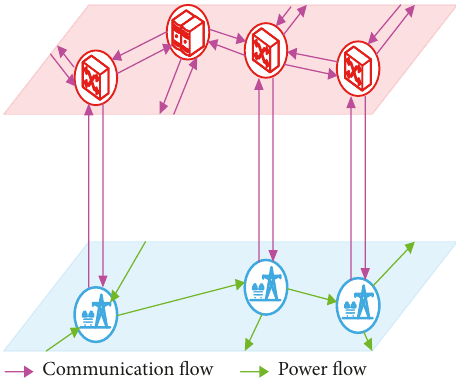
Figure 2: Information flows of electrical and communication networks in smart